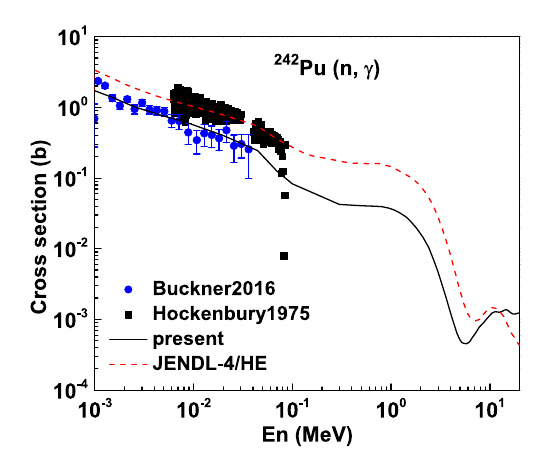
Figure 6. Calculated result of fission cross section (solid line) for n + 244 Pu reaction compared with the experimental data and the evaluated data from TENDL (dash-dotted line).